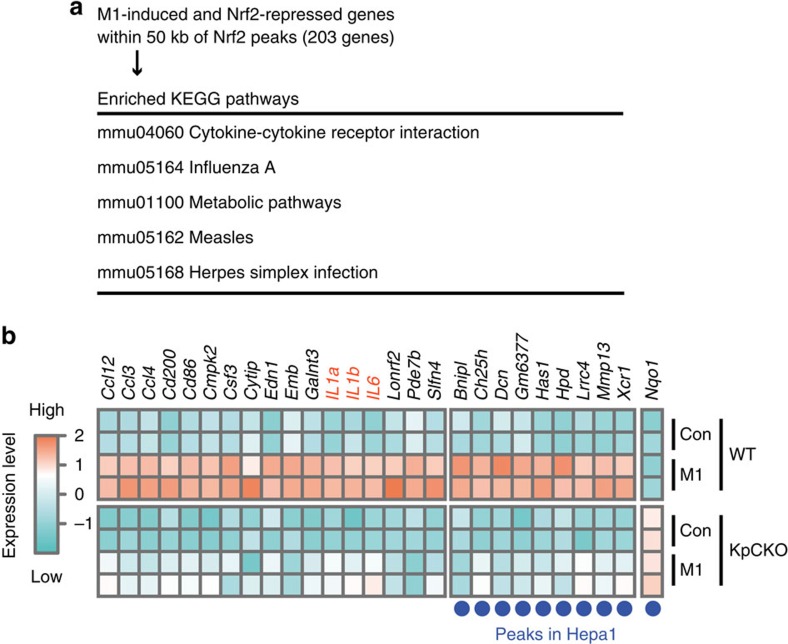
Microarray and ChIP-seq analyses of Keap1-deficient BMDMs.(a) KEGG pathway analysis on M1-induced and Nrf2-repressed genes within 50 kb of Nrf2 peaks detected in KpCKO-M1 samples. The top five pathways are presented. (b) Expression profiles of representative M1-induced genes repressed by Nrf2. BMDMs from two independent WT and KpCKO mice were either untreated (Con) or treated with M1 stimulation (M1, 5-ng ml−1 LPS and 10-ng ml−1 IFNγ) for 6 h and rendered for microarray analysis. Each row represents the mRNA expression level in the corresponding mice depicted as colours from turquoise (low) to coral (high). Each column represents one of 26 genes located within 50 kb of the Nrf2-binding peaks in KpCKO-M1 BMDMs, whose expression was induced by M1 stimulation in WT BMDMs (fold change >2) and repressed by Keap1-deficiency in M1-stimulated BMDMs (fold change <−4). The expression of Nqo1 is displayed to show the expression pattern of typical Nrf2 target genes. Blue dots under the figure represent genes within 50 kb of the Nrf2-binding peaks obtained in DEM-treated Hepa1 cells. Note that the inflammation-related genes are accumulated in the left group of genes, which is inhibited by Nrf2 in a macrophage-specific manner.